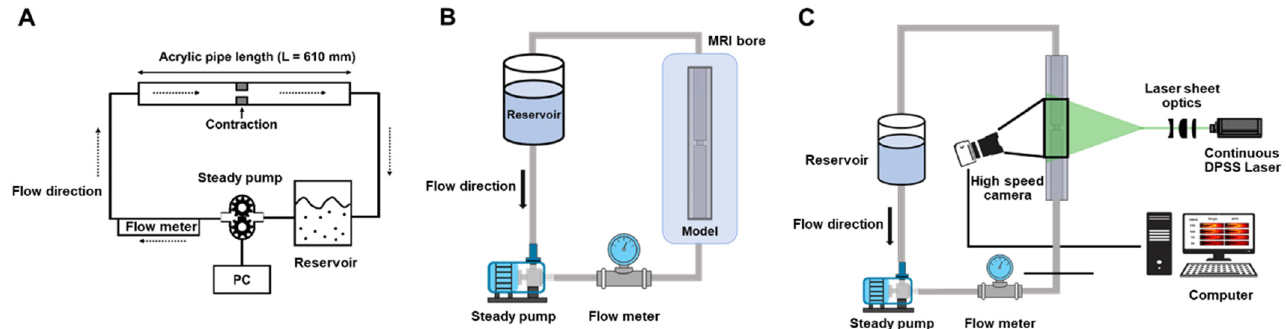
Figure 1. Schematics of the experimental setup. ( A ) the flow circuit. ( B ) 4D flow MRI. ( C ) particle image velocimetry.